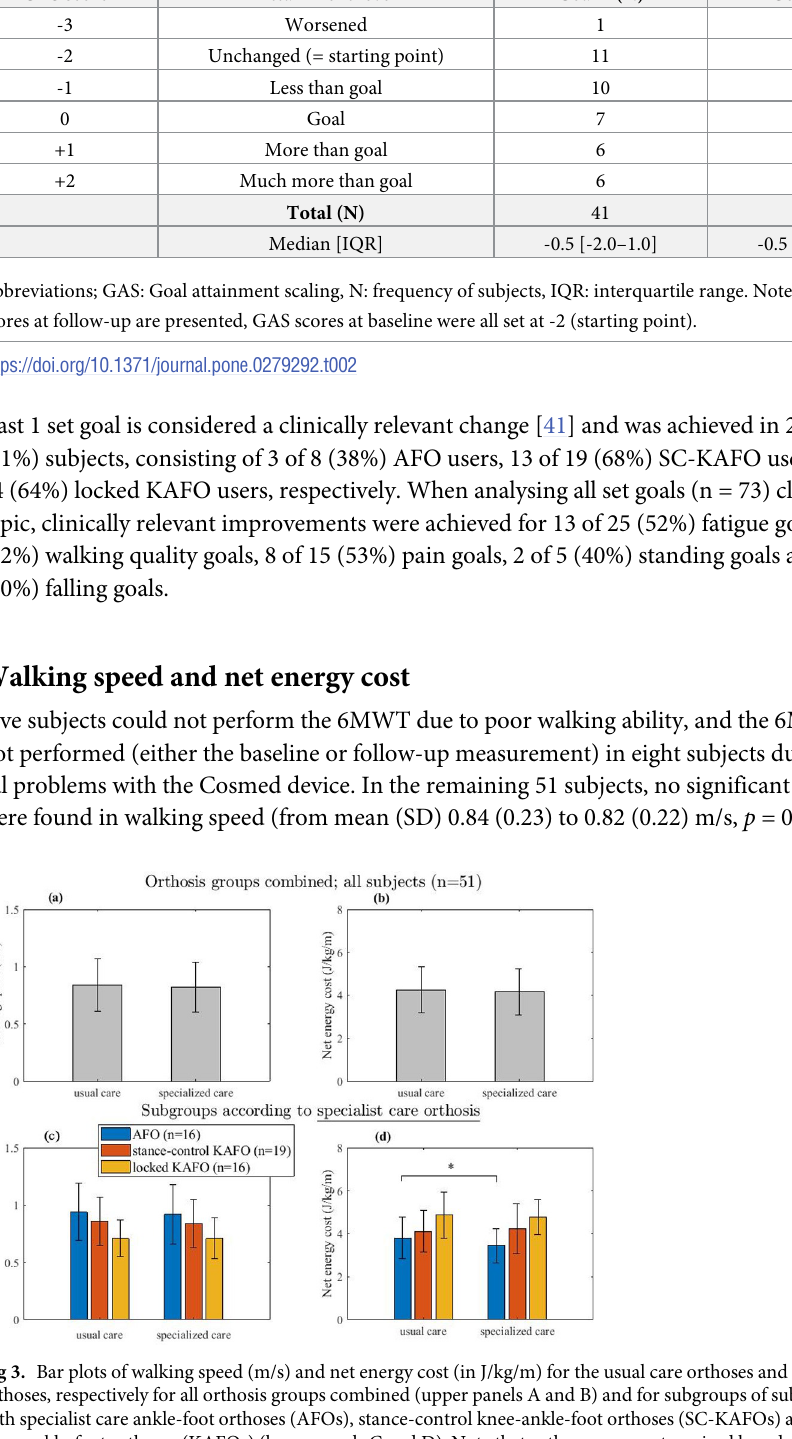
Table 2. GAS scores for specialist care orthoses at the follow-up measurement. GAS score